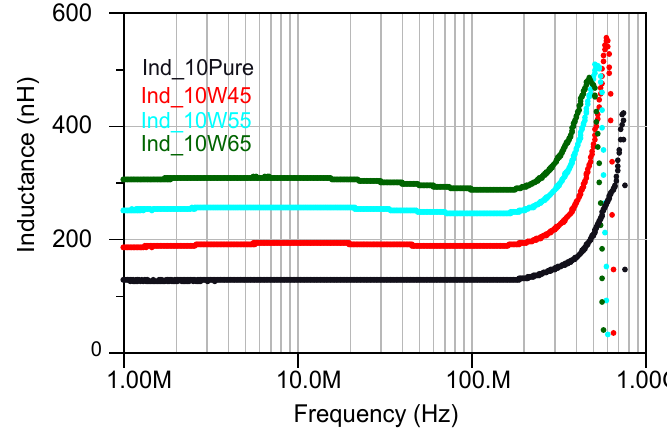
Figure 11. Inductance of the inductors with 10 turns having cores with different percentage of the magnetic powder Ind_10 pure is represents the inductors with pure epoxy core, Ind_XWY stands for inductors having a solenoid made of X turns and core made out of Y% magnetic powder mixed with the